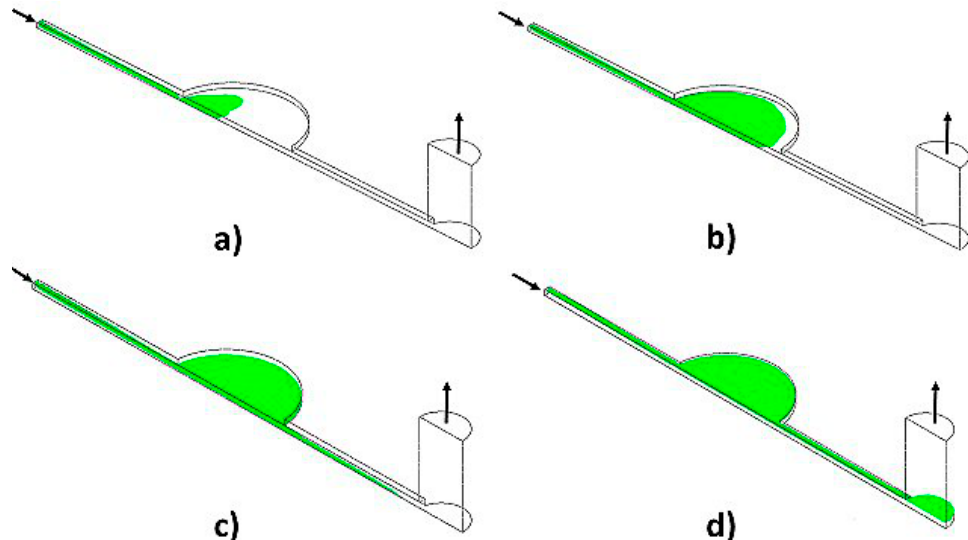
Figure 4. Free-surface during microchannel flooding at an inlet liquid flow rate of 5 μ L/min ( a ) 20 s